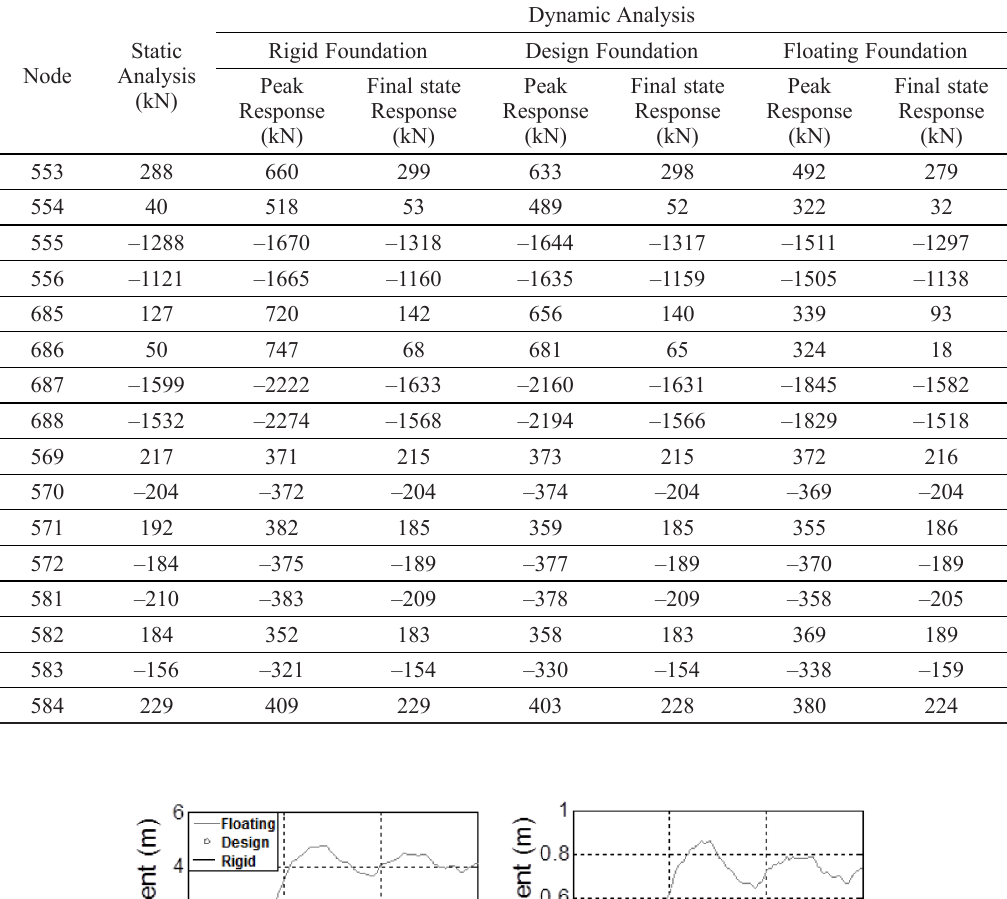
Table 6. Axial forces in some members of the tower GTS 01 due to rupture of the conductor cable bundle 01